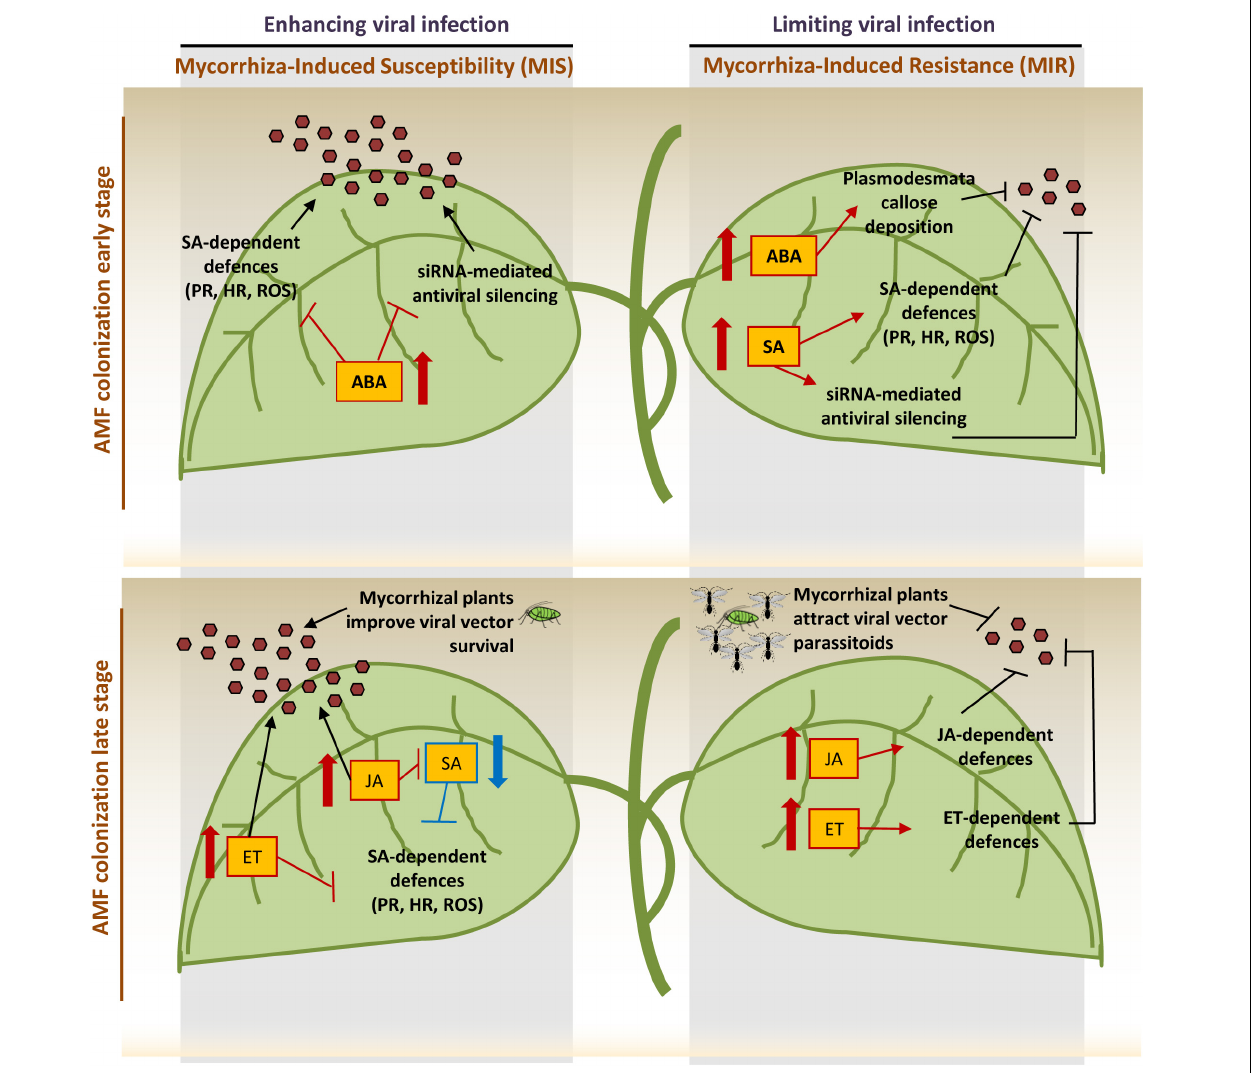
FIGURE 1 | Visual dissection of the events during AMF colonization and virus infection: changes in hormones levels and related processes may enhance (left) or limit (right) viral infection leading to the final outcome of the complex tripartite interaction. In the early stage of mycorrhization, the increase of salicylic acid (SA) induces the priming of SA-dependent defenses, the major defensive pathway against viruses, and enhances the siRNA-mediated antiviral silencing. At the same time, abscisic acid (ABA) increases with both positive and negative consequences on plant defenses: it induces callose deposition on plasmodesmata, limiting cell-to-cell movement, suppresses SA signaling transduction, thus inhibiting defenses controlled by this pathway and weakens siRNA-antiviral system. In the late AMF colonization stage, the increase of jasmonate (JA) and ethylene (ET) induces the priming of JA- and ET-dependent defenses. JA has been shown to reduce viral symptoms at early infection stage but increase susceptibility in late infection stage; on the other hand, JA treatment decreases viral titre during geminivirus infection. ET antagonizes the pathway downstream the SA signaling and may be involved in symptom development, viral systemic movement and formation of necrotic lesions. However, spraying plants with the ET precursor 1-aminocyclopropane-l-carboxylic acid may reduce viral titre. Finally, mycorrhizal plants have been shown to improve aphid survival and increase attractiveness toward aphids parasitoids. PR: pathogenesis-related proteins, HR: hypersensitive response, ROS: reactive oxygen species, brown hexagones indicate viral particles (Lozano-Durán et al., 2011; Cameron et al., 2013; Alazem and Lin, 2015; Volpe et al.,